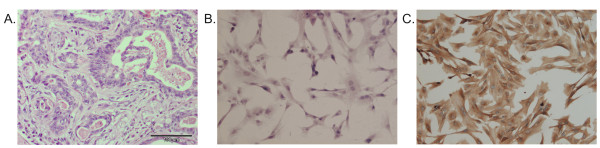
Cancer associated fibroblasts isolated from canine mammary cancer. Representative pictures of A. Canine mammary complex carcinoma (HE staining) tissue from which the carcinoma-associated fibroblasts were isolated. B. The culture of carcinoma-associated fibroblasts (CAFs) isolated from the canine mammary complex carcinoma (HE staining) and C. Carcinoma-associated fibroblasts (CAFs) isolated from canine complex mammary carcinoma revealed a strong vimentin expression (brown color). The pictures were obtained using Olympus BX60 microscope (at the magnification of 200×).